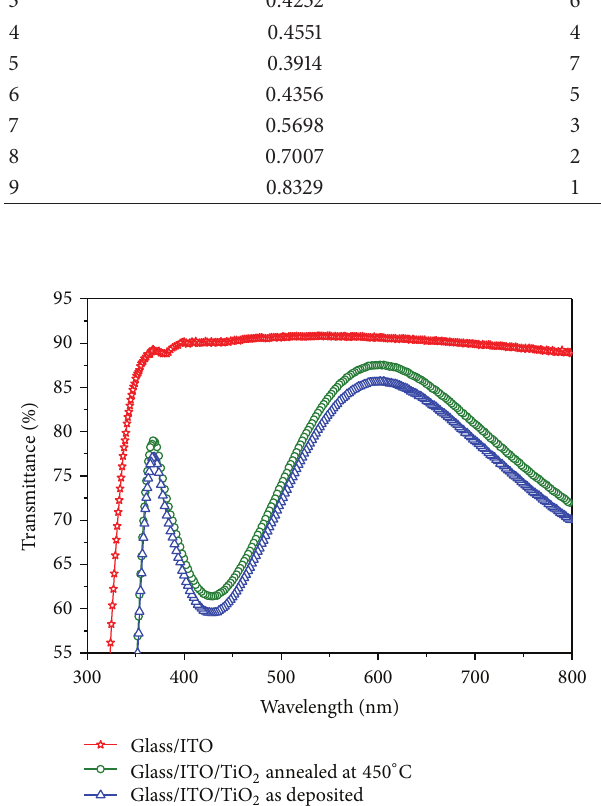
Figure 2: The optical transmittance spectra for TiO 2 compact